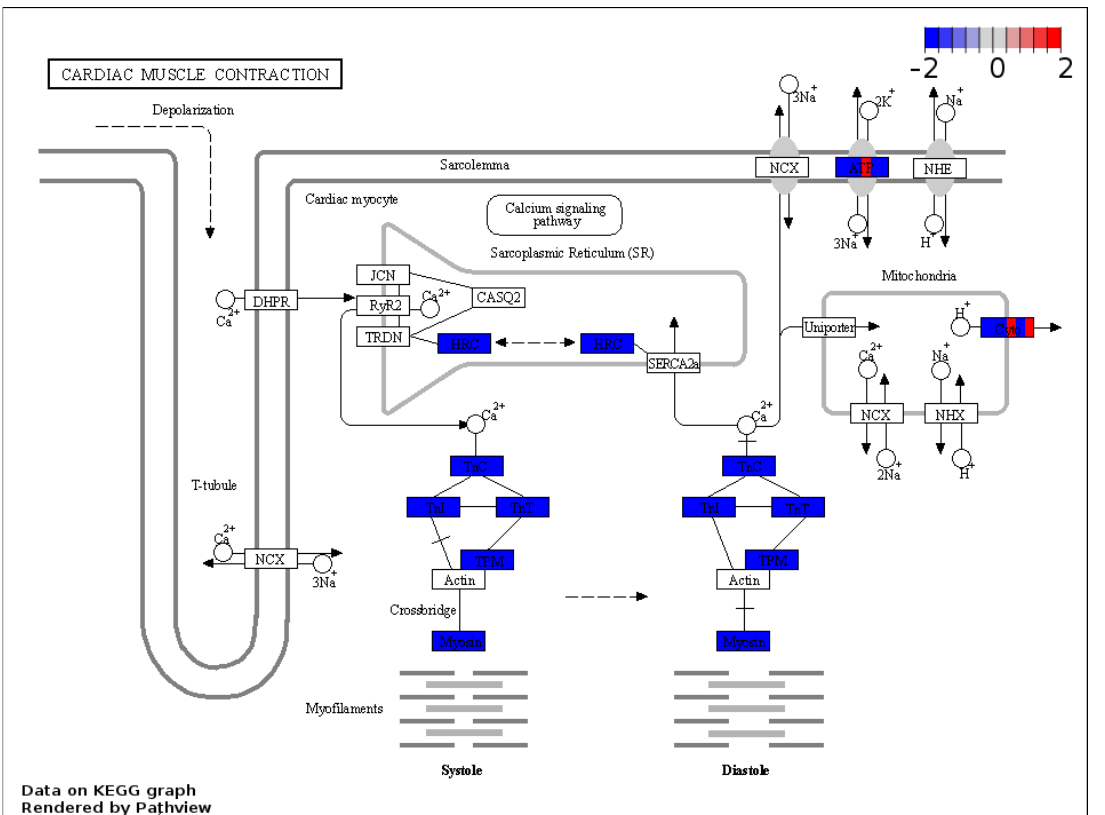
Figure 5. KEGG analysis showed concordant downregulated expression patterns of cardiac-specific troponins and the myosin complex. Visual representation of leading-edge protein subsets based on the Kyoto Encyclopedia of Genes and Genomes database. Each protein was divided into six sections and was colored based on the relative expression count compared with the normocholesterolemic group. Pathway graphs were created with Pathview Web (https://pathview.uncc.edu/home accessed on 17 January 2022).